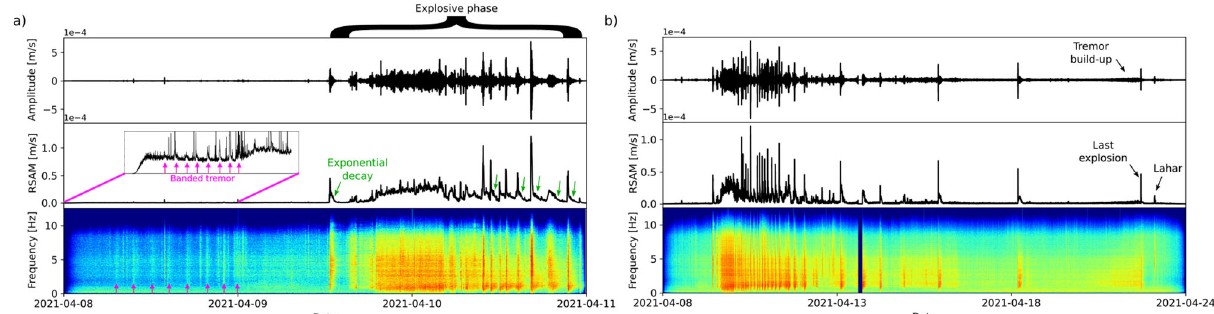
Fig. 4 Main features of seismicity during explosive phase. a Vertical time series at station SVV, RSAM and spectrogram showing the main features of the signal during the fi rst 3 days: banded tremor, continuous and discrete explosions with exponential decays. b Vertical time series at station SVV, RSAM and spectrogram showing the main features of the whole explosive phase: increasing inter-explosion time, tremor build up to the last explosion and an abrupt end of the low-frequency tremor two hours after the referenced explosion. It also shows a lahar signal around 8 h after.